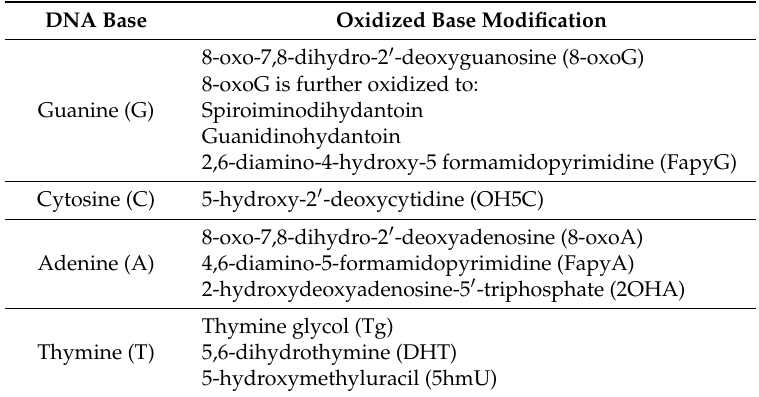
Table 1. DNA base modifications that commonly exist after oxidative